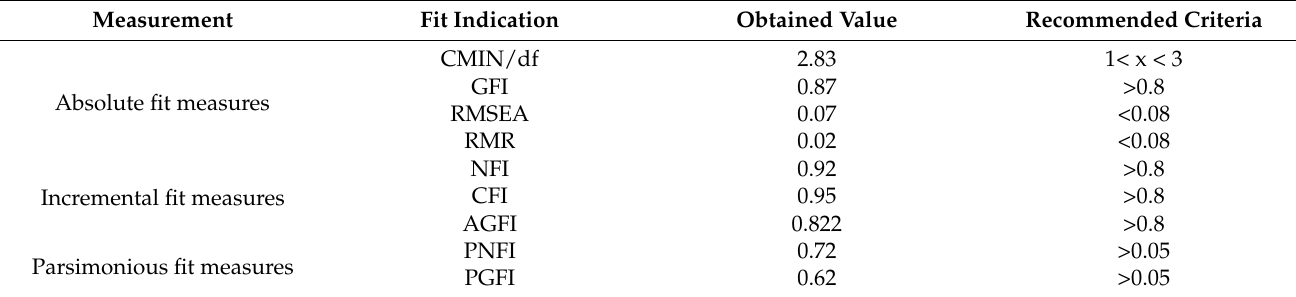
Table 5. Measurement for model fit *.